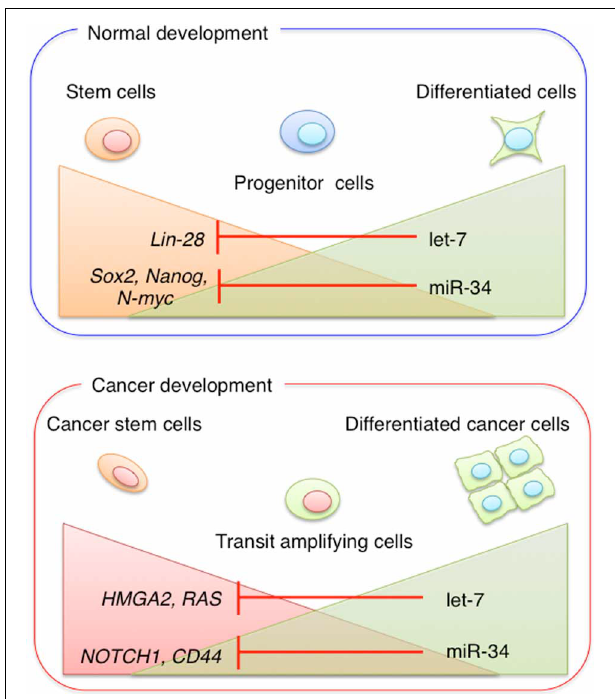
FIGURE 2 | miRNA in stem cells and cancer stem cells. Stem cell-specific miRNAs play important roles in tumor initiation and development. During normal development, pluripotent stem cells become more restricted to specific cell lineages. Progenitor cells are committed to generating different cell types, whereas fully differentiated cells have a low potential for self-renewal. The expression levels of miR-34 and let-7 family members increase during differentiation. During cancer development, CSC properties are regulated by the balance between miRNA expression and the expression of miRNA target genes.